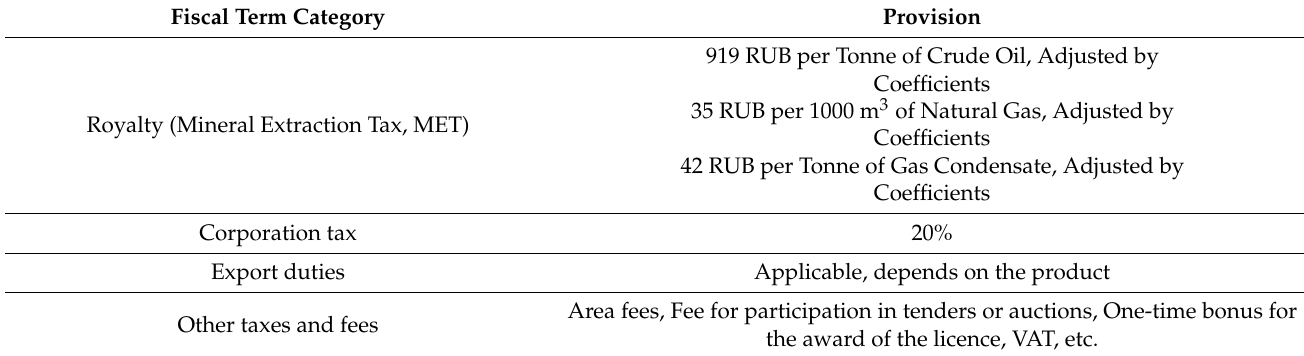
Table 2. Fiscal terms of exploration and production of hydrocarbons in the Russian Federation (T&R contracts). Fiscal Term